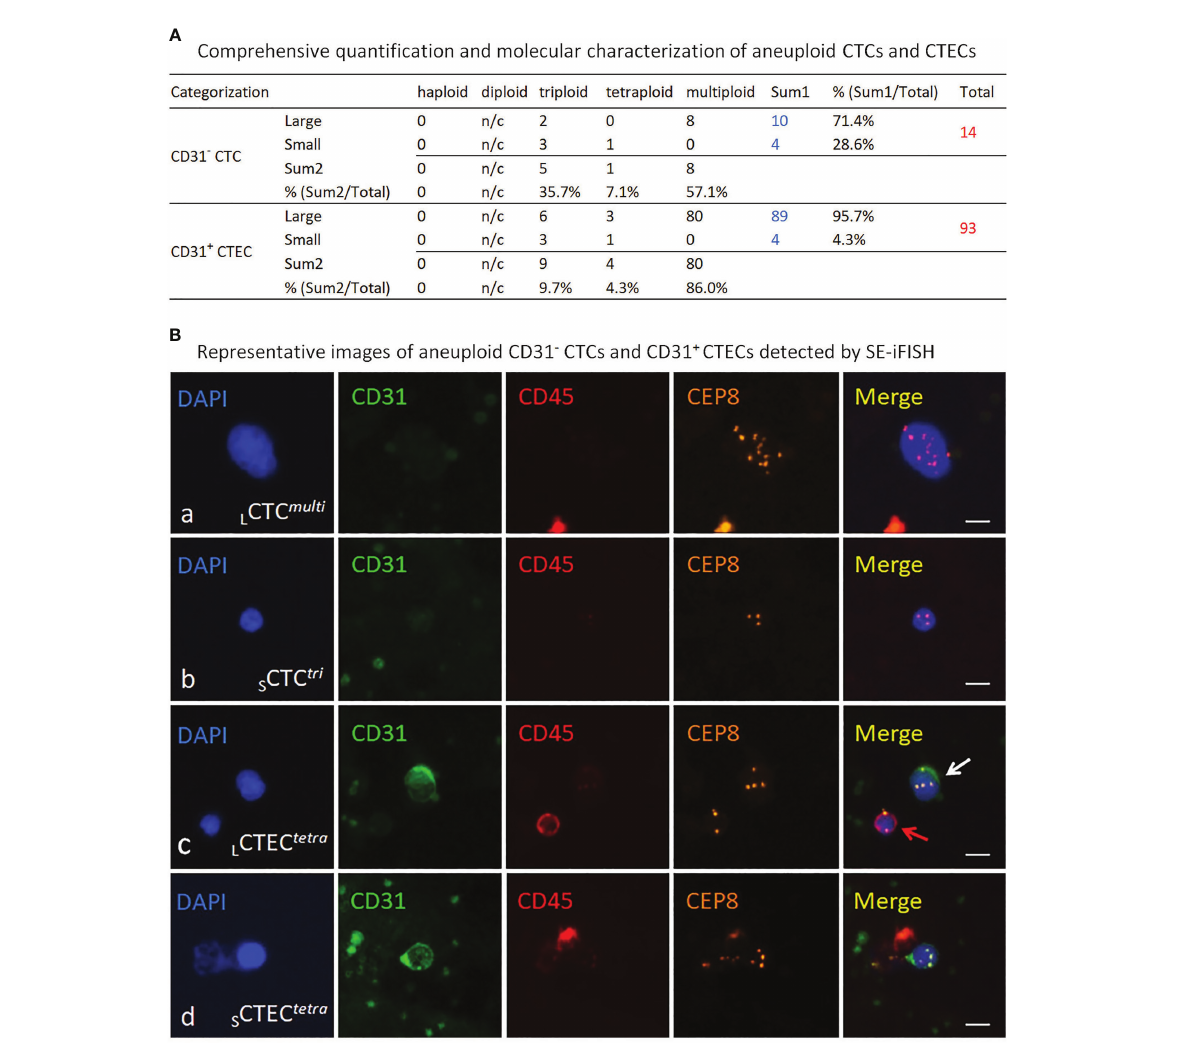
FIGURE 2 Detection and molecular characterization of aneuploid CD31 - CTCs and CD31 + CTECs performed by SE-iFISH. (A) Quantitative analysis of the detected CTCs and CTECs. Among 14 CTCs, 10 of them are large cells (10/14 = 71.4%), remaining 4 CTCs are in small cell size (28.6%). Different degrees of aneuploidy harbored by CTCs are trisomy 8 (35.7%), tetrasomy 8 (7.1%), and multisomy 8 ( ≥ pentasomy 8, 57.1%), respectively. Most of detected 93 CTECs are large cells (89/93 = 95.7%), and the rest are small CTECs (4/93 = 4.3%). Degrees of aneuploidy in CTECs are 9.7% for triploidy, 4.3% for tetraploidy and 86% for multiploidy. n/c, not counted. (B) Representative images of the detected CTCs and CTECs. Ba, a large CTC with multiploid chr8 (CD31 - /CD45 - , >5 mm WBC size , L CTC multi ). Bb, a small CTC with trisomy 8 ( ≤ 5 mm WBC , S CTC tri ). Bc, a large tetraploid CTEC (CD31 + /CD45 - , L CTEC tetra ) is indicated by a white arrow; a diploid CD45 + WBC is indicated by a red arrow. Bd, a small tetraploid CTEC ( S CTEC tetra ). Bars=5 m